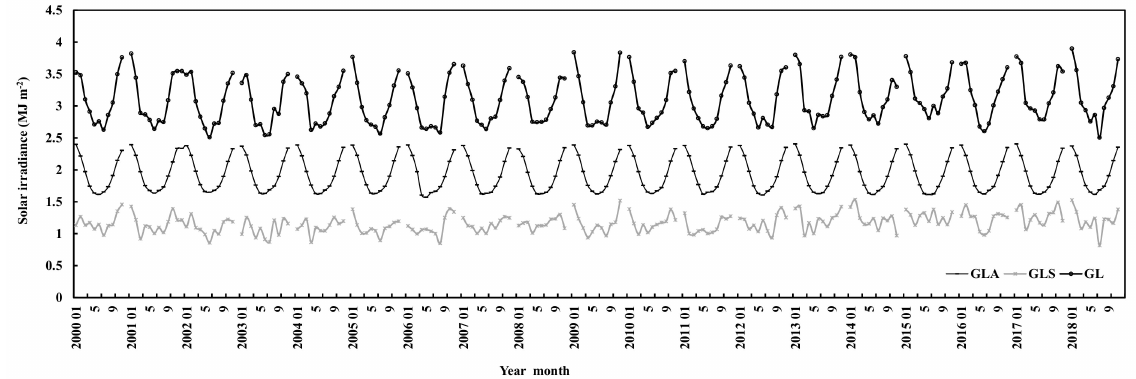
Figure 8. Monthly losses of global solar irradiance caused by absorbing and scattering substances (G LA , G LS ) and total loss (G L = G LA + G LS ) at Sodankylä.